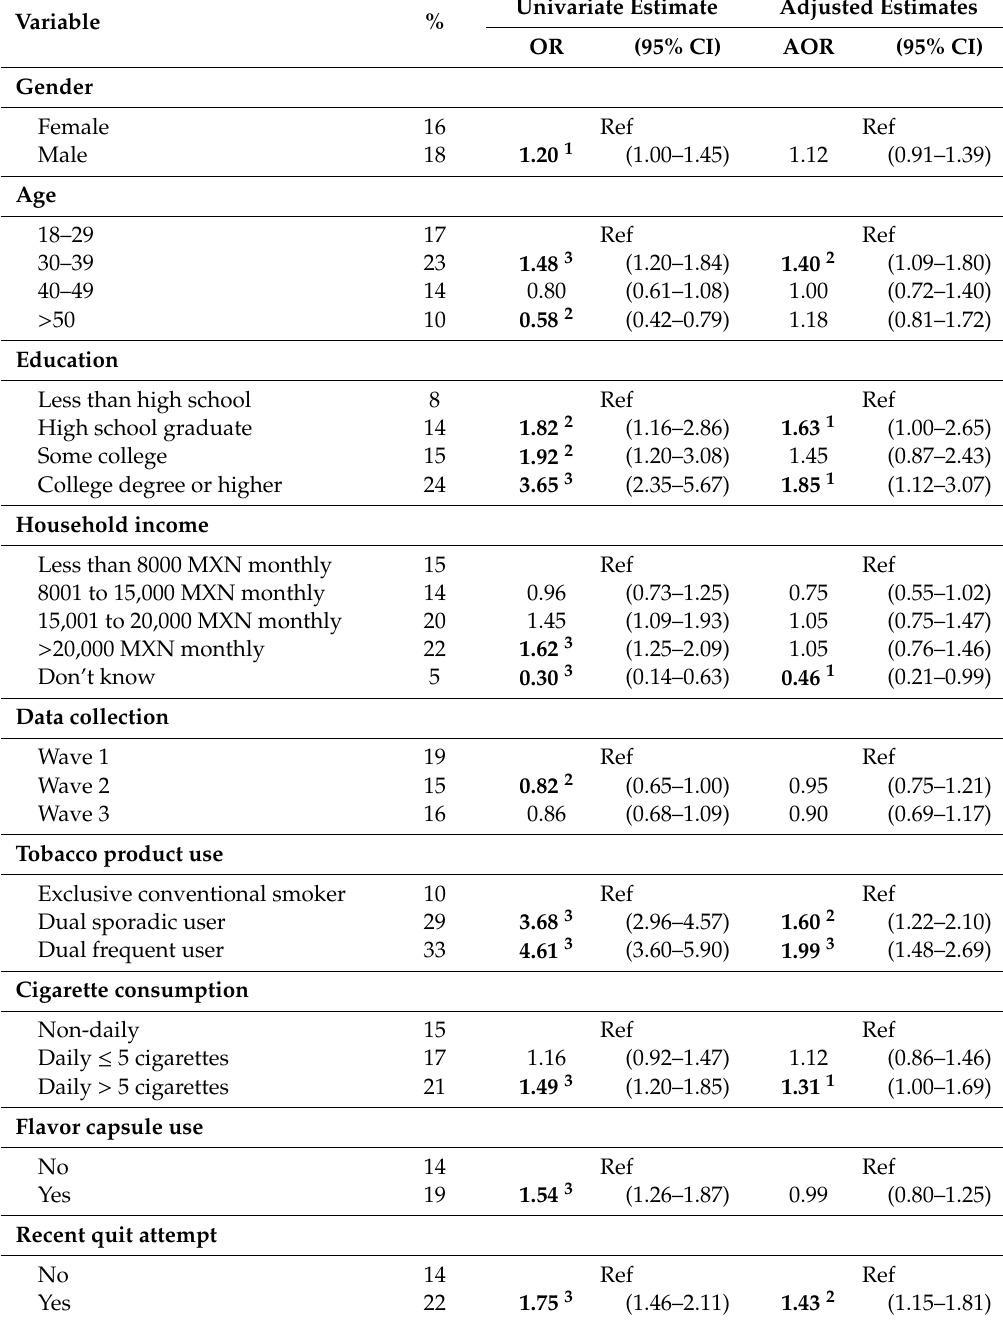
Table 2. Factors associated with the awareness of IQOS (‘I Quit Ordinary Smoking’) among adult smokers ( n =